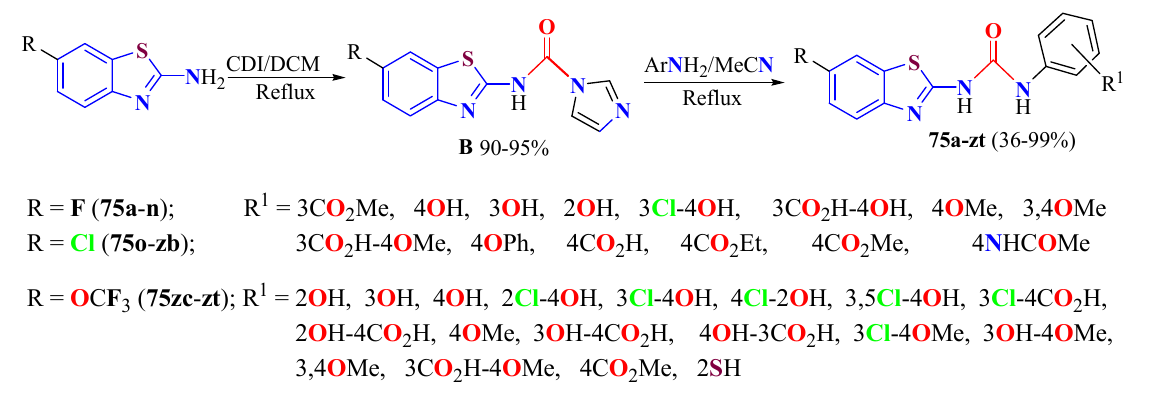
Scheme 29. Synthesis of 6-substituted aryl-UBTs 75a – zb and Frentizole based aryl-UBTs 75zc – zt .